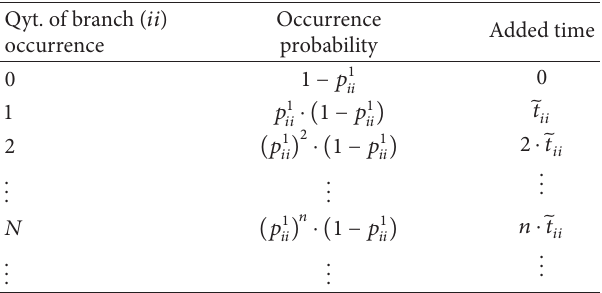
Table 1: Added time in other branches separating from node ( 𝑖 ). See Figure